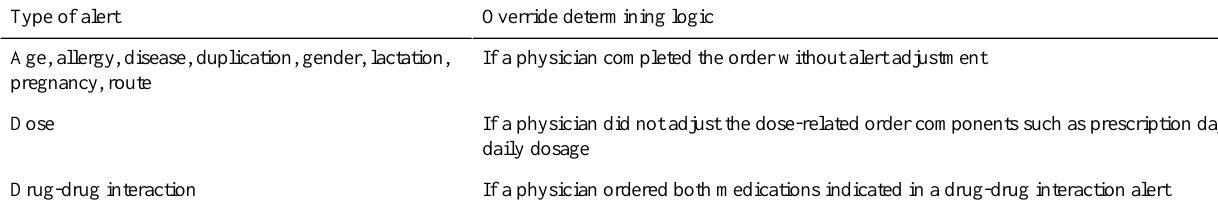
Override determining logicType of